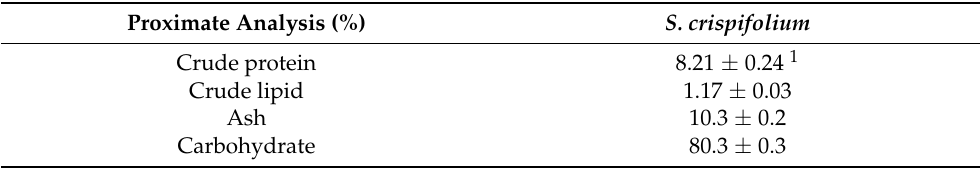
Table 1. Proximate composition of Sargassum crispifolium